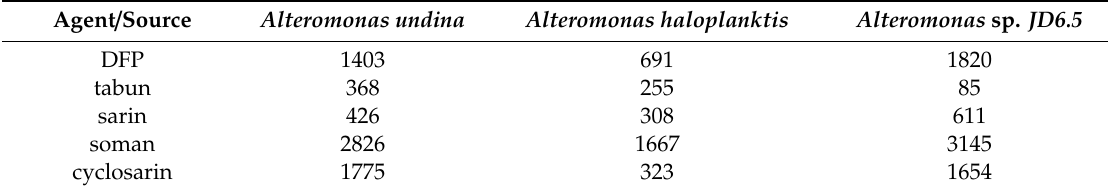
Table 2. Substrate specific activity (U.mg − 1 ) of various Alteromonas OPAAs [8].